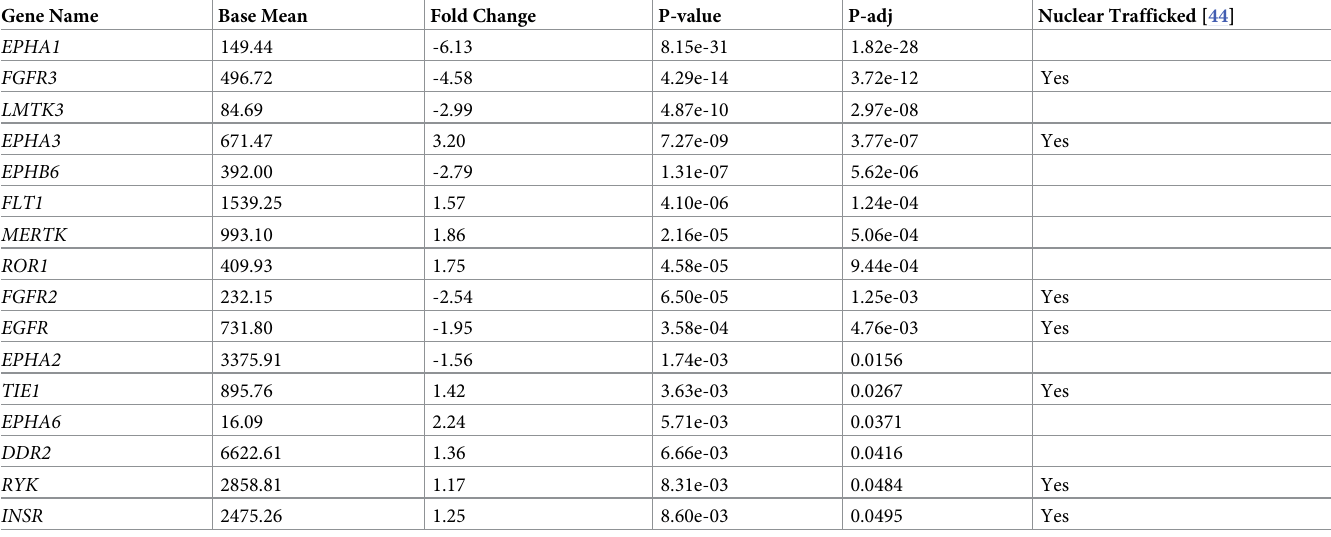
Table 2. Differential expression from primary tumor to metastatic samples in receptor tyrosine kinases (RTKs). Gene